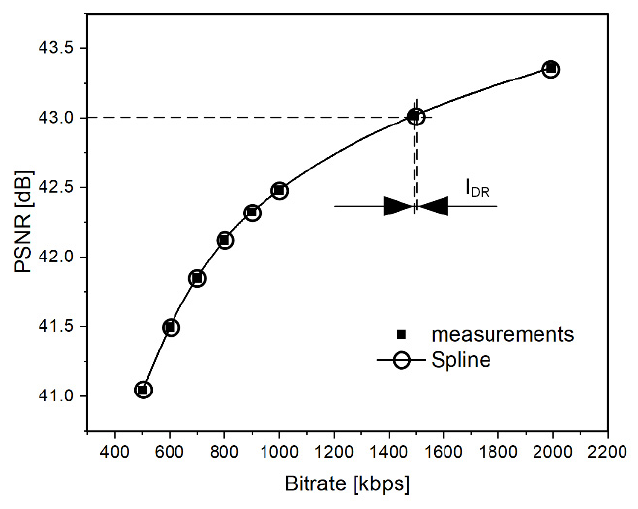
Figure 5. Calculation of the ‘interpolation delta rates’.